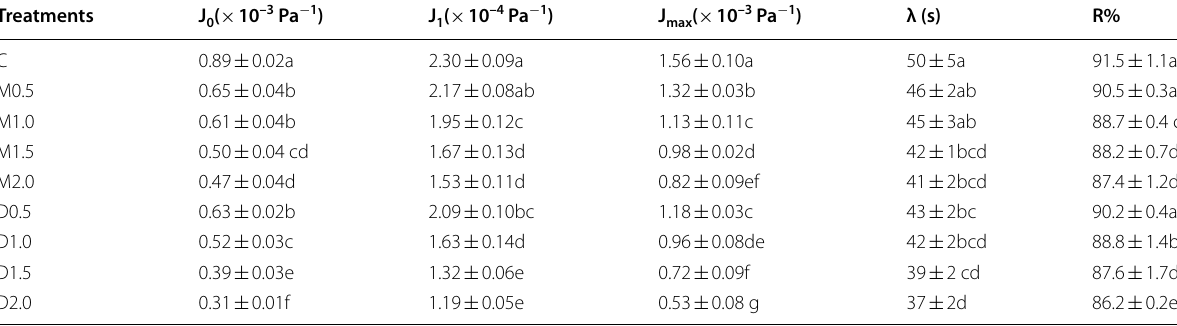
Different letters (a-g) in a column indicate significant differences (p < 0.05)